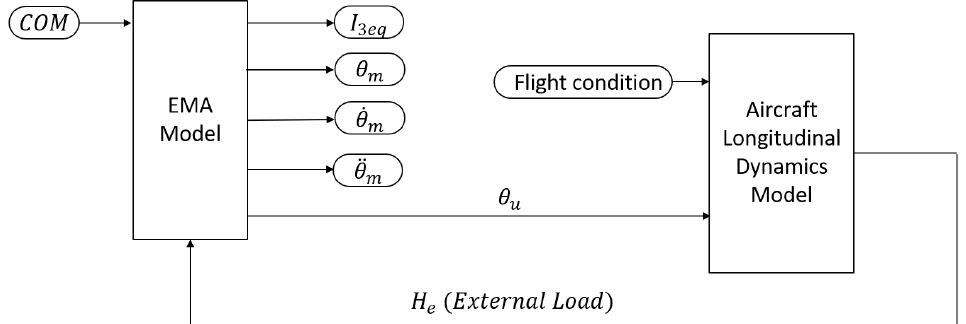
Figure 2. Overview of the top level of the Simulink